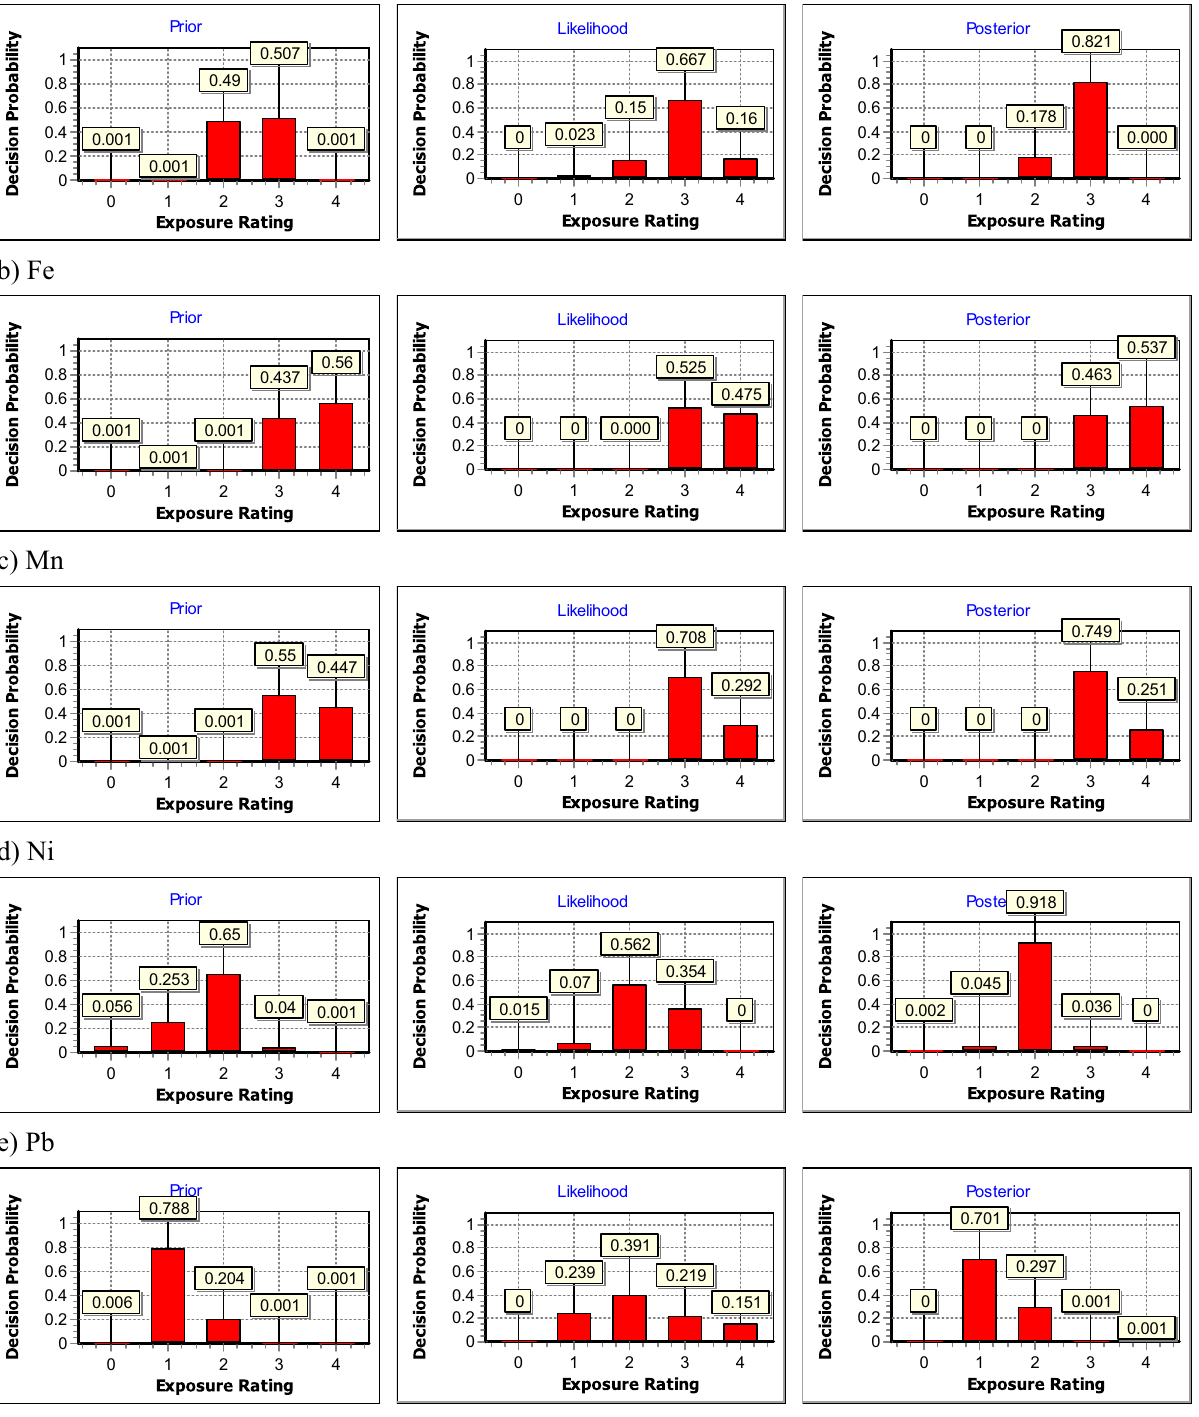
Figure 2. The resultant prior, likelihood, and posterior distributions for ( a ) Cr, ( b ) Fe, ( c ) Mn, ( d ) Ni, and ( e ) Pb fume concentrations in NF region,